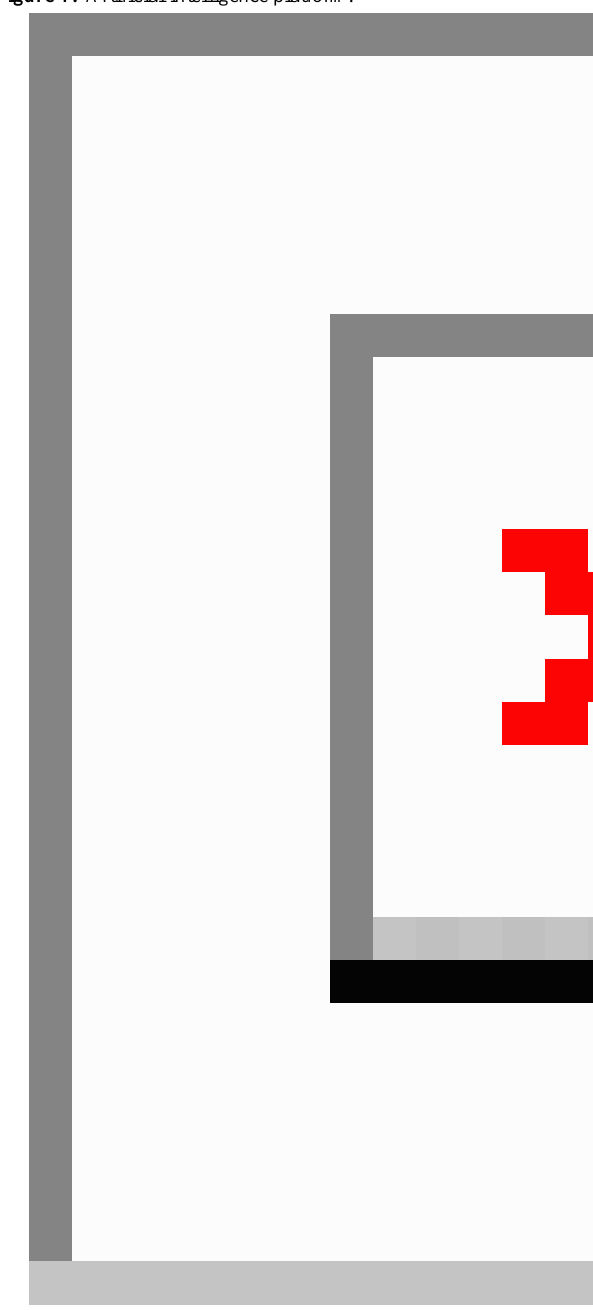
Figure 1. Artificial intelligence